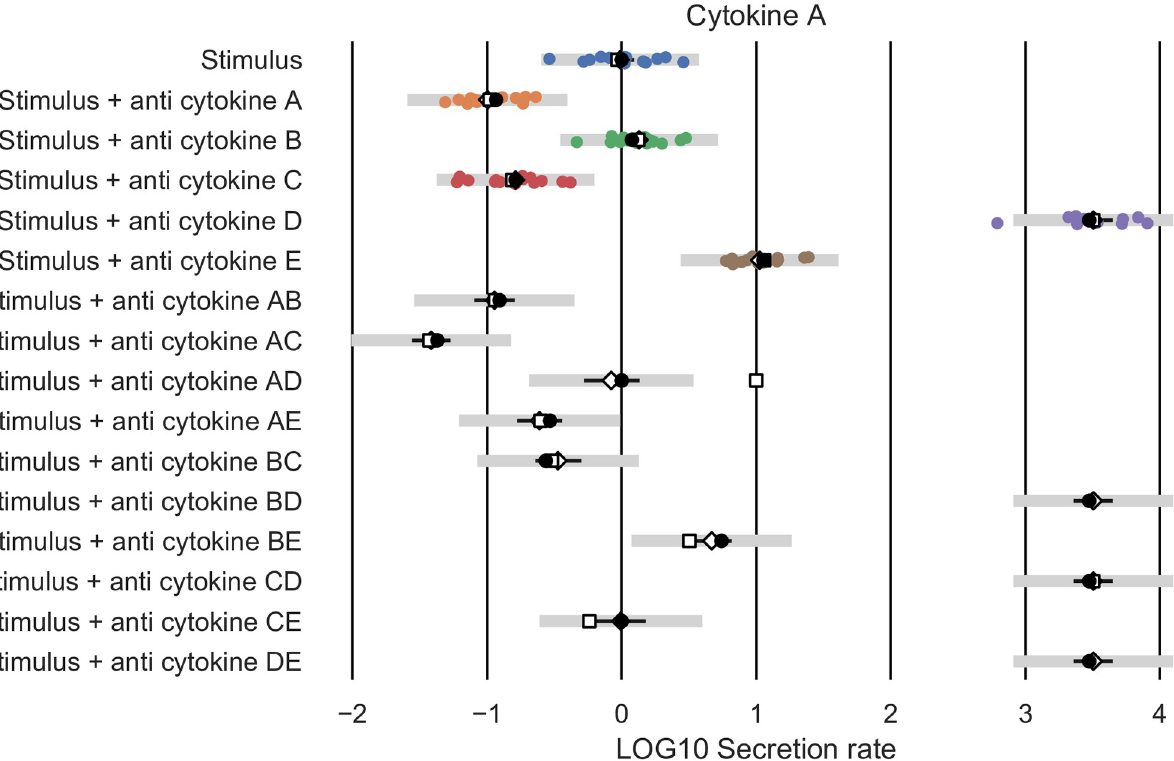
Fig 11. The synthetic dataset for Cytokine A (coloured dots). Model simulations for the mean cytokine secretion of Cytokine A with the edge weights set to the values used to generate the example synthetic dataset (black dots) and model simulations with the edge weights fitted to the synthetic dataset, both for the model configuration containing all significant edges (white, squares), and the selected ten edge model (white, diamonds). The Log10 transformed values 12.4 and 69.5, corresponding to the ‘Anti cytokine BD’ and ‘Anti cytokine DE’ simulations of the model configuration containing all significant edges are not shown for visibility reasons. In 99% of cases, we expect an experimental datapoint (grey lines, validation profile likelihood confidence intervals), or the true mean cytokine secretion rate (black lines, prediction profile likelihood confidence intervals) to lie within the shown intervals for our ten edge test model